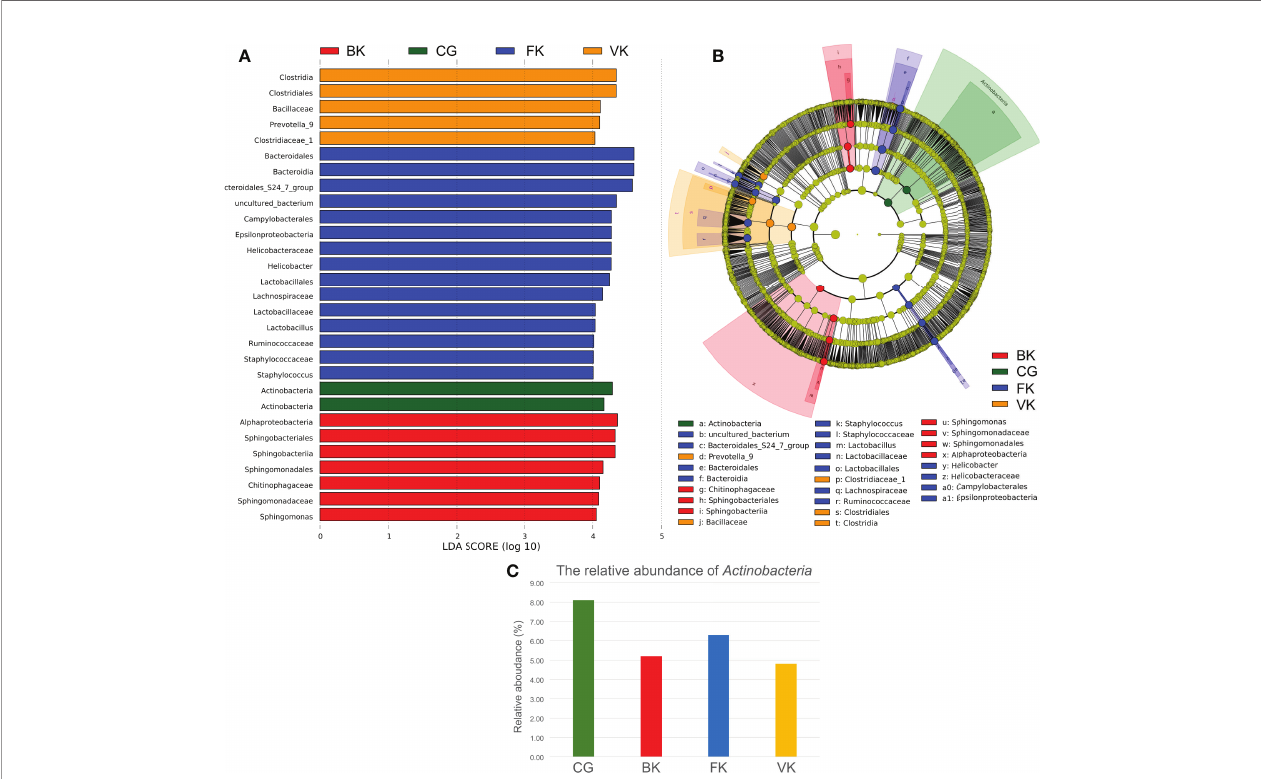
FIGURE 4 | LEfSe indicates that Actinobacteria may be valuable and meaningful for the ocular microbiota. (A) When the score of a taxon is >4.0 with P < 0.01, biomarkers of different taxa for each group are listed in the histogram. (B) The relationship among these taxa is exhibited using a concentric circle fi gure. The circles, from inside to outside, show the phylum, class, order, family, and genus. The colored spots indicate biomarkers of each group. (C) According to the above pictures, the relative content of Actinobacteria decreases in microbial keratitis. (CG, control group - healthy eyes; BK, bacterial keratitis; FK, fungal keratitis; VK, viral